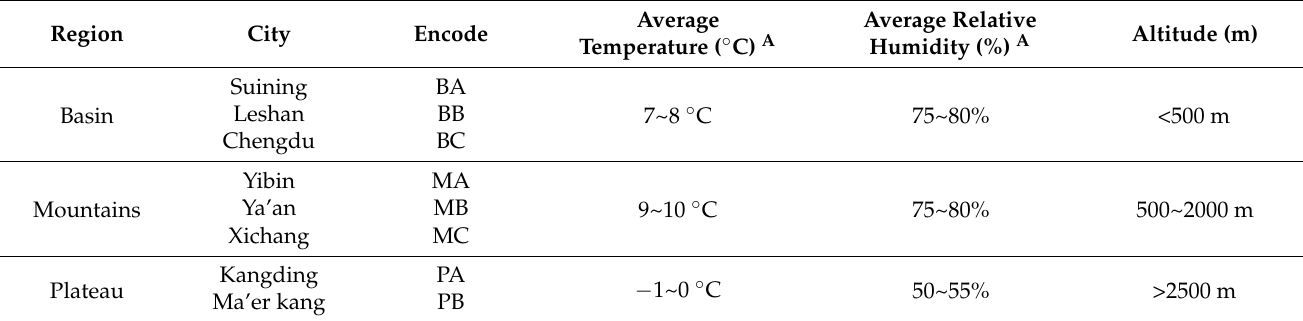
Table 1. The information of the sampling